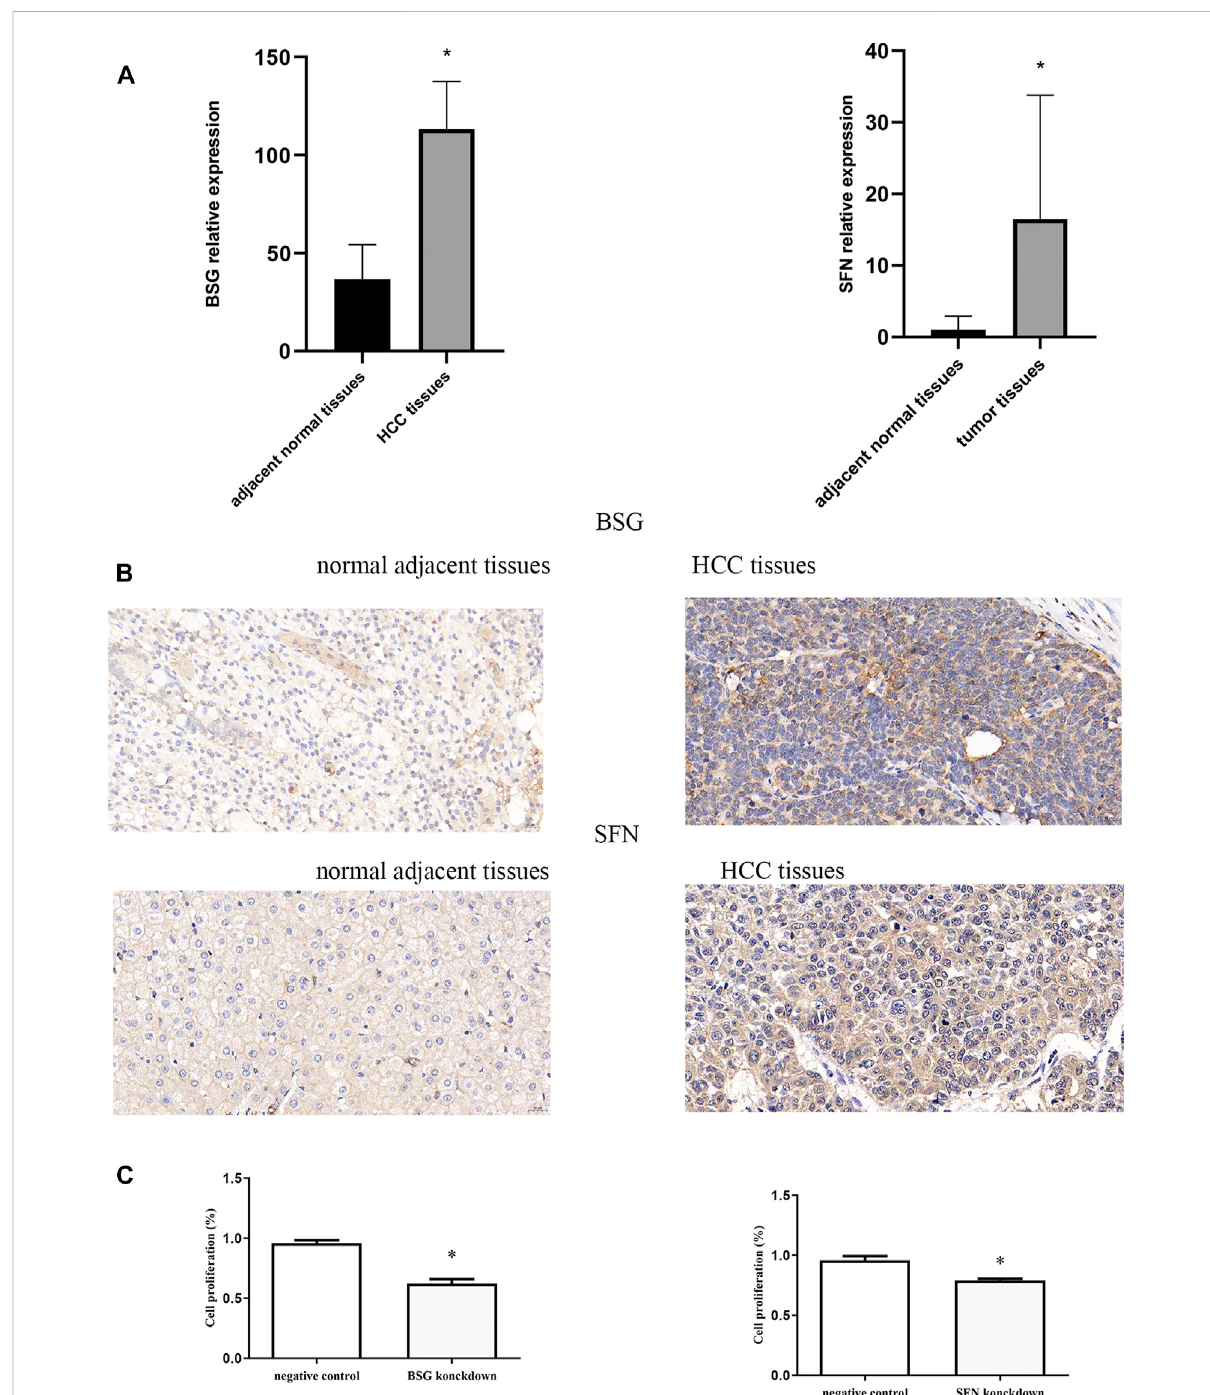
FIGURE 7 Quantitativereal-timePCR,immunohistochemistry,andCCK-8. (A) mRNAexpressionofBSGandSFN. (B) LevelsofBSGandSFNwereanalyzed by IHC. The scale bar represents 20 μ m. (C) Cell proliferation *p <